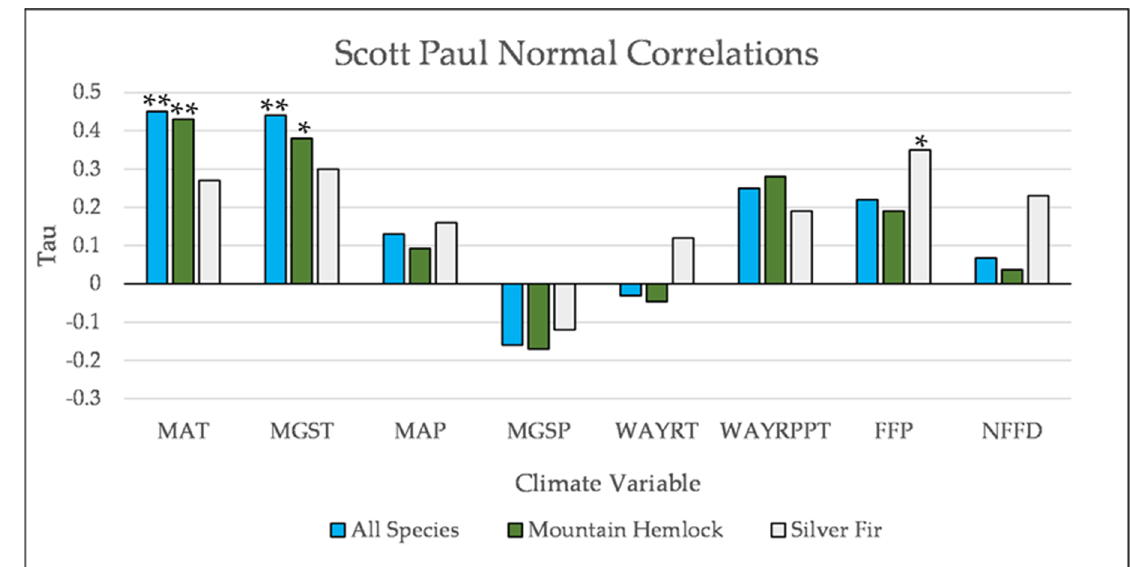
Figure A17. Partial Kendall’s correlation controlled for temperature between snowfall and establishment at Grouse Ridge. * = p -Value < 0.05.